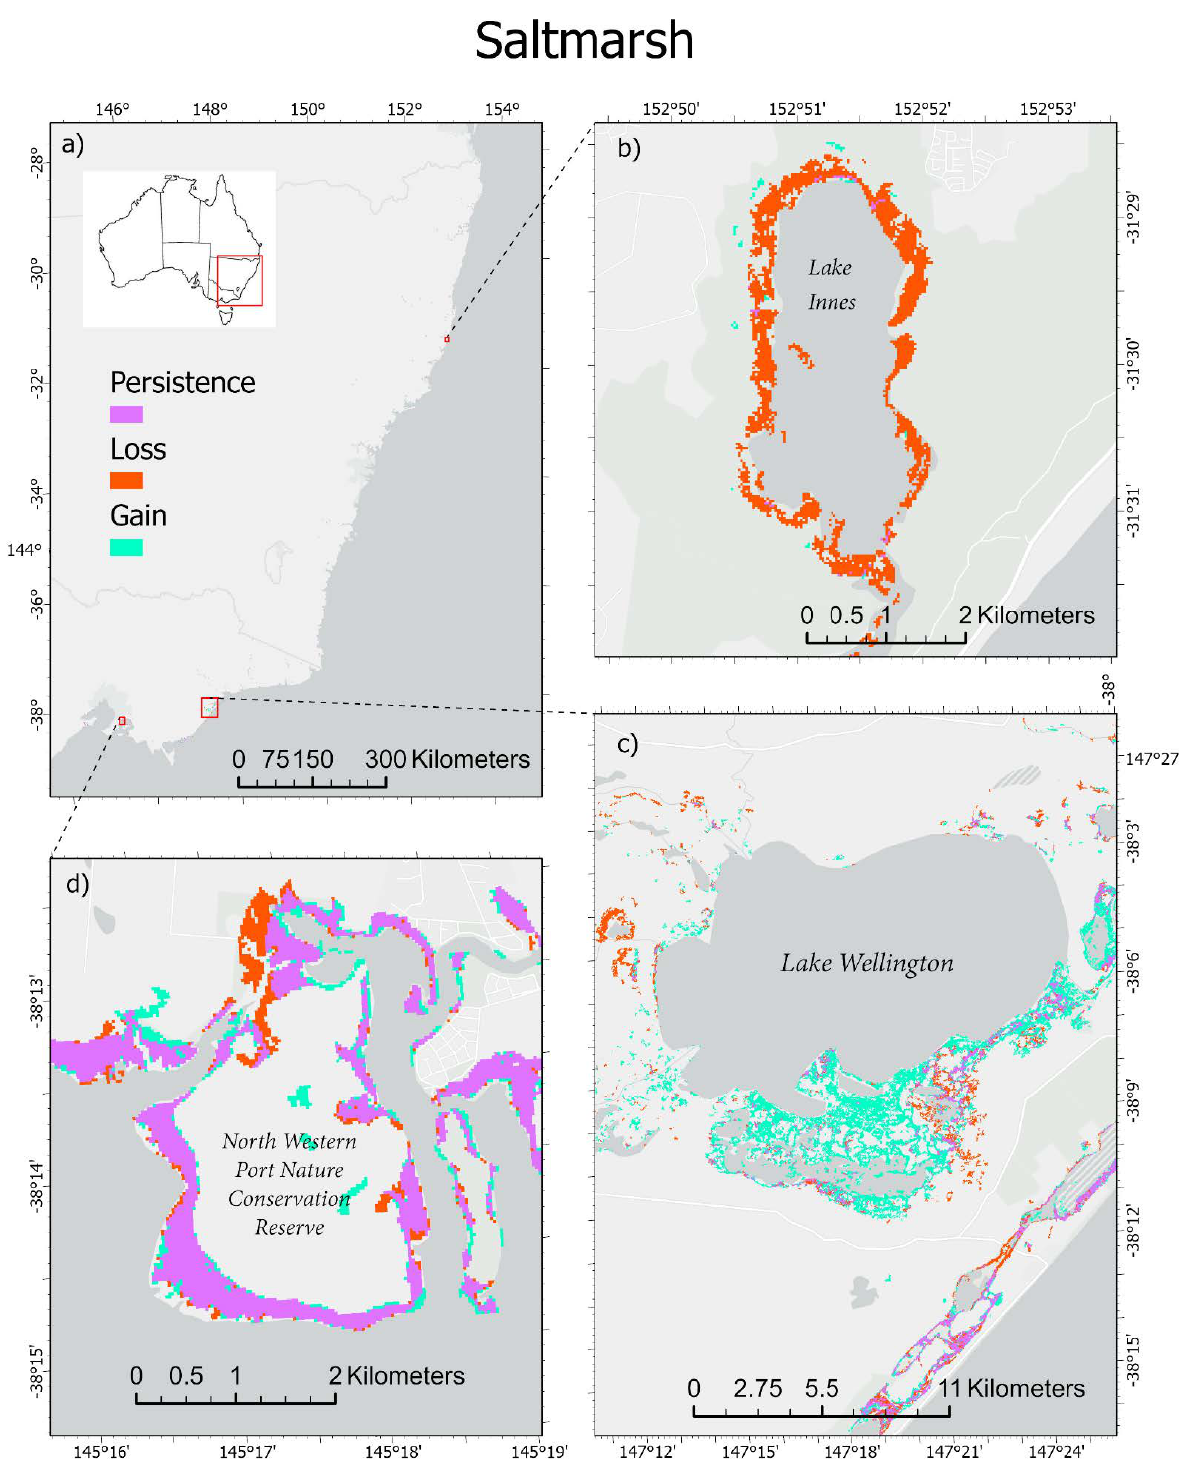
Figure 4. Saltmarsh gains, losses, and persistence between 1991 and 2015 across the south-eastern coast of Australia ( a ), along with several zoomed-in examples ( b – d